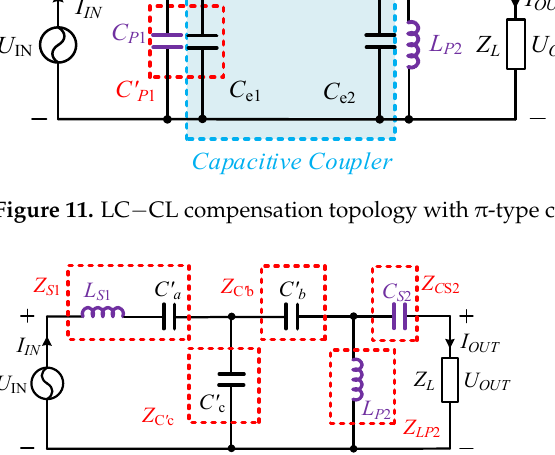
Figure 12. LC − CL compensation topology with T-type coupler model.